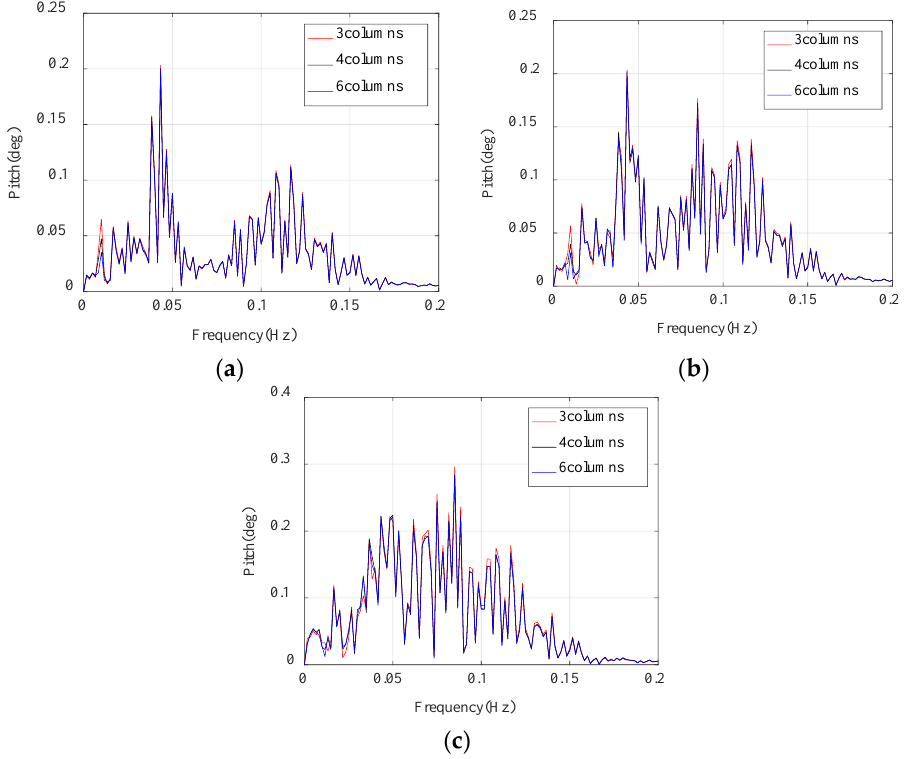
Figure 14. Pitch response spectrum for the three platforms under wave loadings ( a ) LC4, ( b ) LC5, and ( c ) LC6.